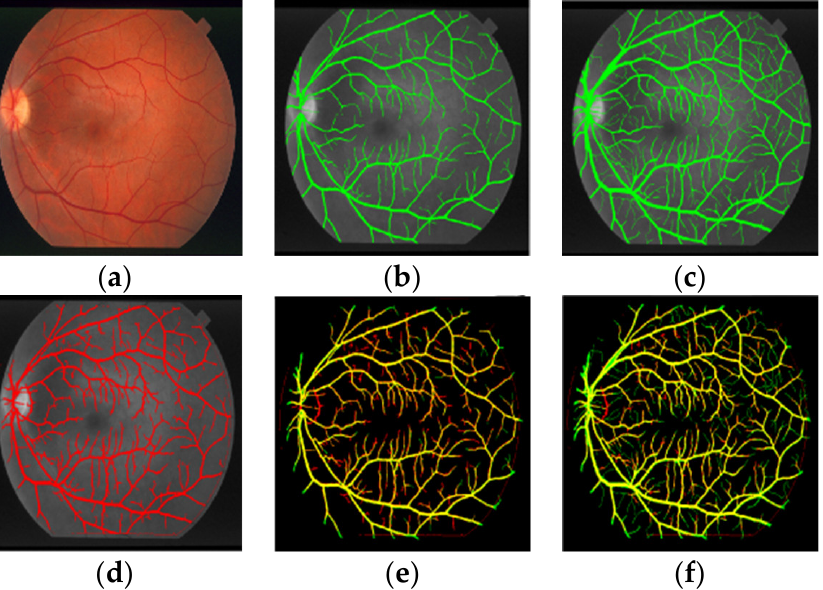
Figure 7. Comparison results of the proposed algorithm with that of experts on STARE im0255. ( a ) STARE image; ( b ) Expert 1 segmentation result; ( c ) Expert 2 segmentation result; ( d ) Segmentation results of the proposed method; ( e ) Difference between segmentation result of proposed method and expert 1 segmentation result; ( f ) Difference between segmentation result of proposed method and expert 2 segmentation result.